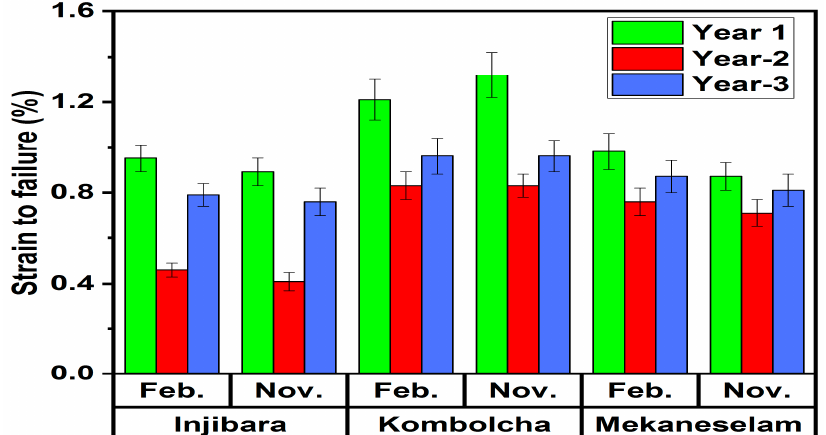
Figure 11. Strain to failure of bamboo composite in Ethiopia BFRPPCs. Table 1. Standard methods of measuring unnotched impact strength .